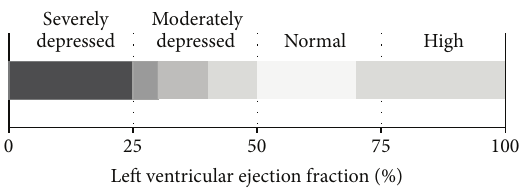
Figure 2: Domains of left ventricular ejection fraction associated with clinical